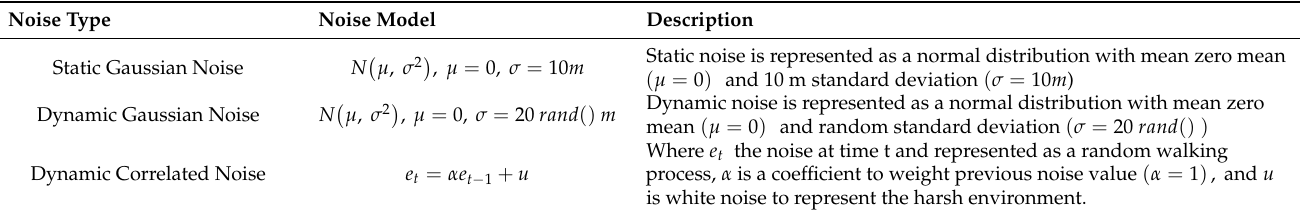
Table 1. The used noise models.